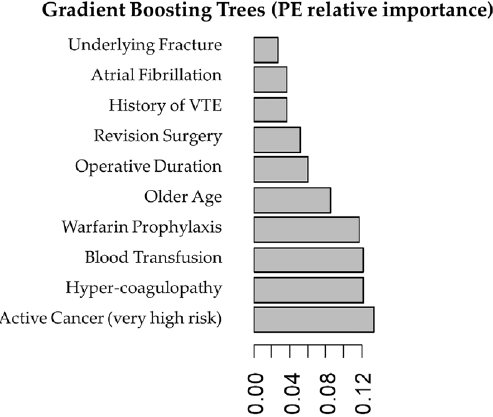
Figure 4. Top ten important predictors for pulmonary embolus (PE) as captured by gradient boosting tree analysis.